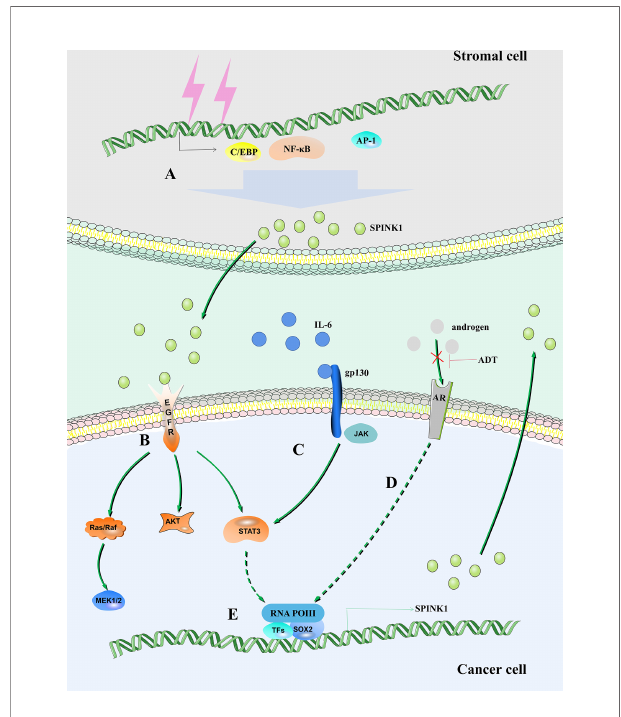
FIGURE 1 | SPINK1 regulates the fate of tumor cells. (A) DNA damage in stromal cells leads to increased expression of SPINK1 mediated by NF- k B, activating protein-1 (AP-1) and C/EBP. (B) SPINK1 binds to EGFR to activate the EGFR signaling pathway. (C) IL-6/STAT3 axis regulates the expression of SPINK1. (D) Androgen receptor regulates the expression of SPINK1. (E) SOX2 is recruited to the SPINK1 promoter leading to SPINK1